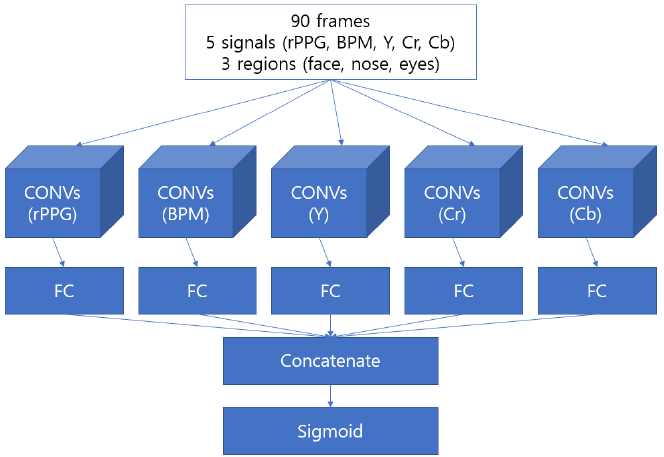
Figure 9. Structure of our CNN-based model with every method implemented.